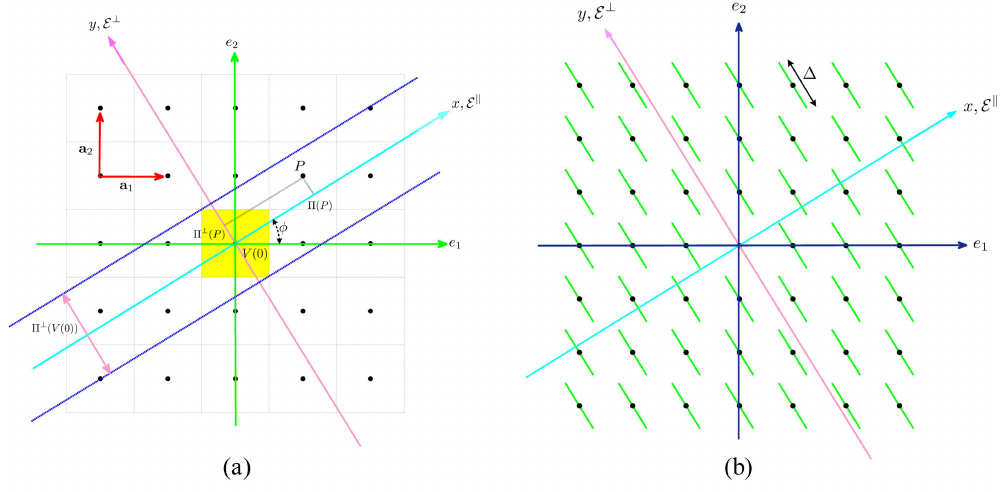
Figure 4. 2D embedding of the Fibonacci quasicrystal (QC) showing ( a ) the selection window for the 2D hyper-lattice projection and ( b ) the decorated hyper-lattice of a Fibonacci QC with atomic surfaces (ASs) of length ∆